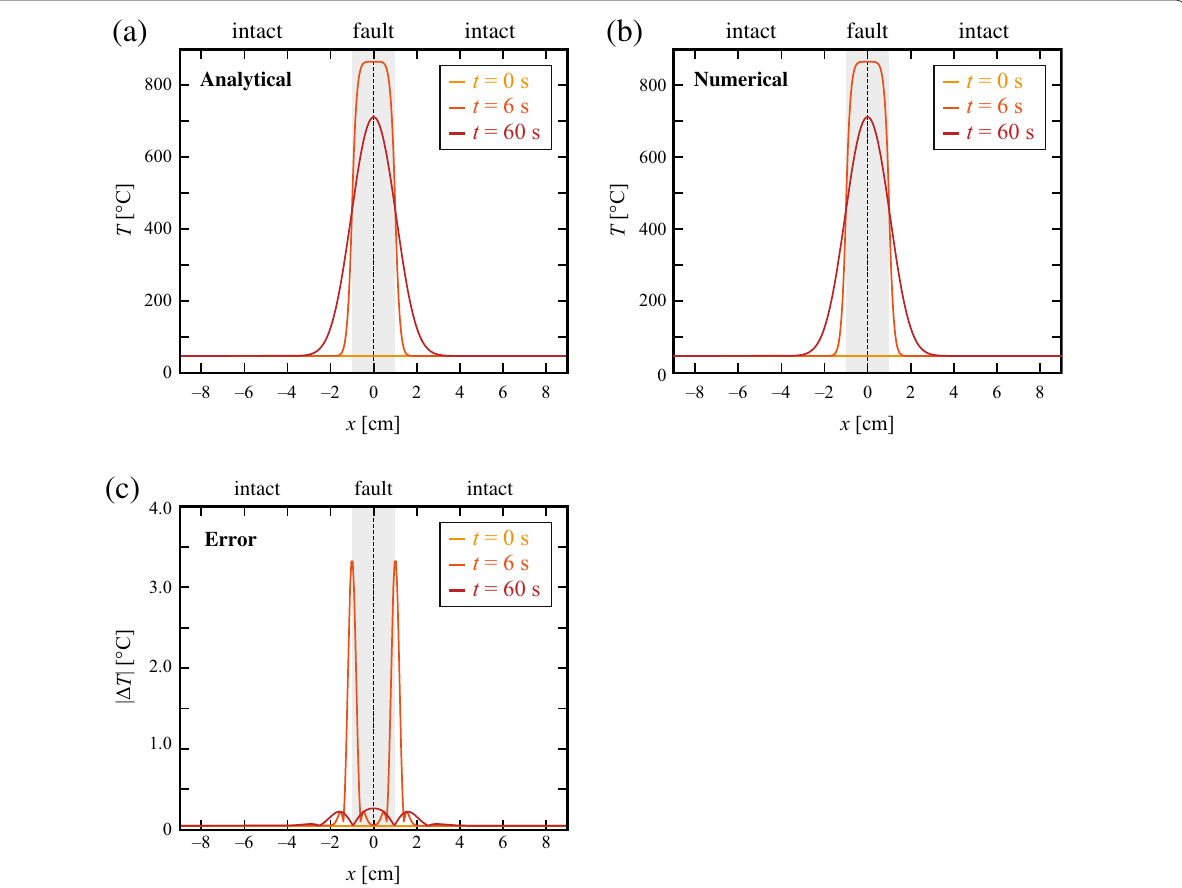
Fig. 3 Example solutions to Eq. (12). The spatial distributions of the a analytical and b numerical solutions, and the c absolute deviations between these two solutions (numerical error), are plotted. Equations (19) and (20) were used to calculate the analytical solutions. The numerical solutions were obtained by the explicit Runge–Kutta method of order 5(4) (see main text for details). All of the parameters used to obtain the solutions are listed in Table 1